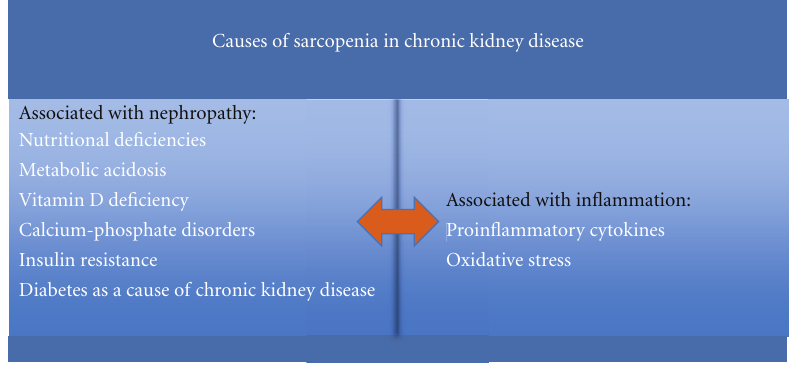
Figure 1: Causes of sarcopenia in chronic kidney disease